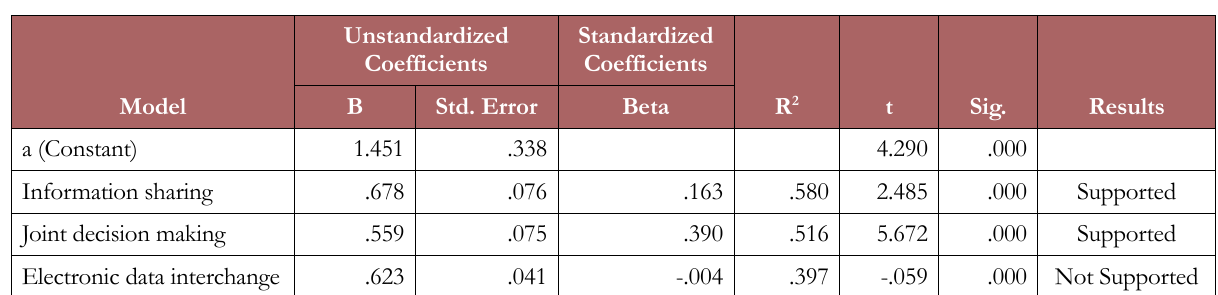
Table 3. Correlation analysis